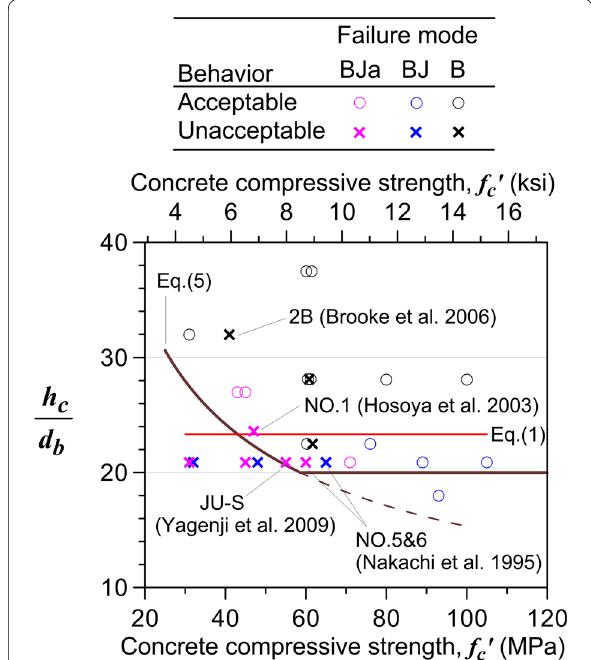
Fig. 5 Relations of the h c / d b ratio, measured concrete compressive strength, and evaluated hysteresis performance for joints with Grade 490 or 500 MPa beam bars.